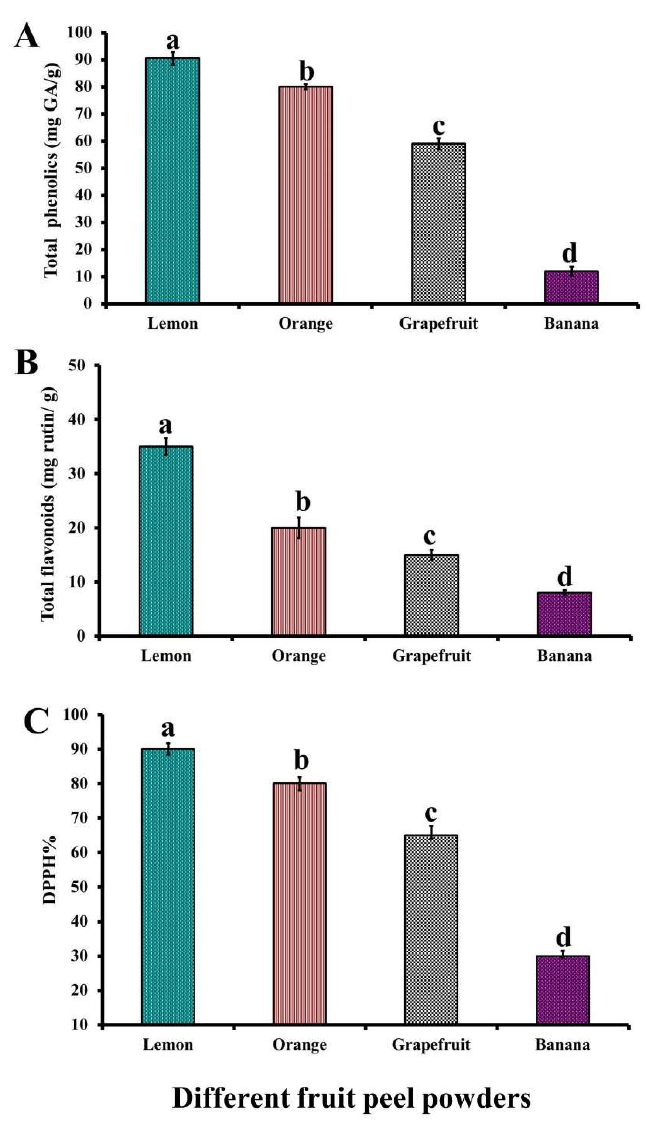
Figure 1. Total phenolic ( A ) and flavonoid ( B ) contents, and DPPH% ( C ) ac-tivity of different fruit peel powders. Columns marked by different letters showed significant differences ( p < 0.05).